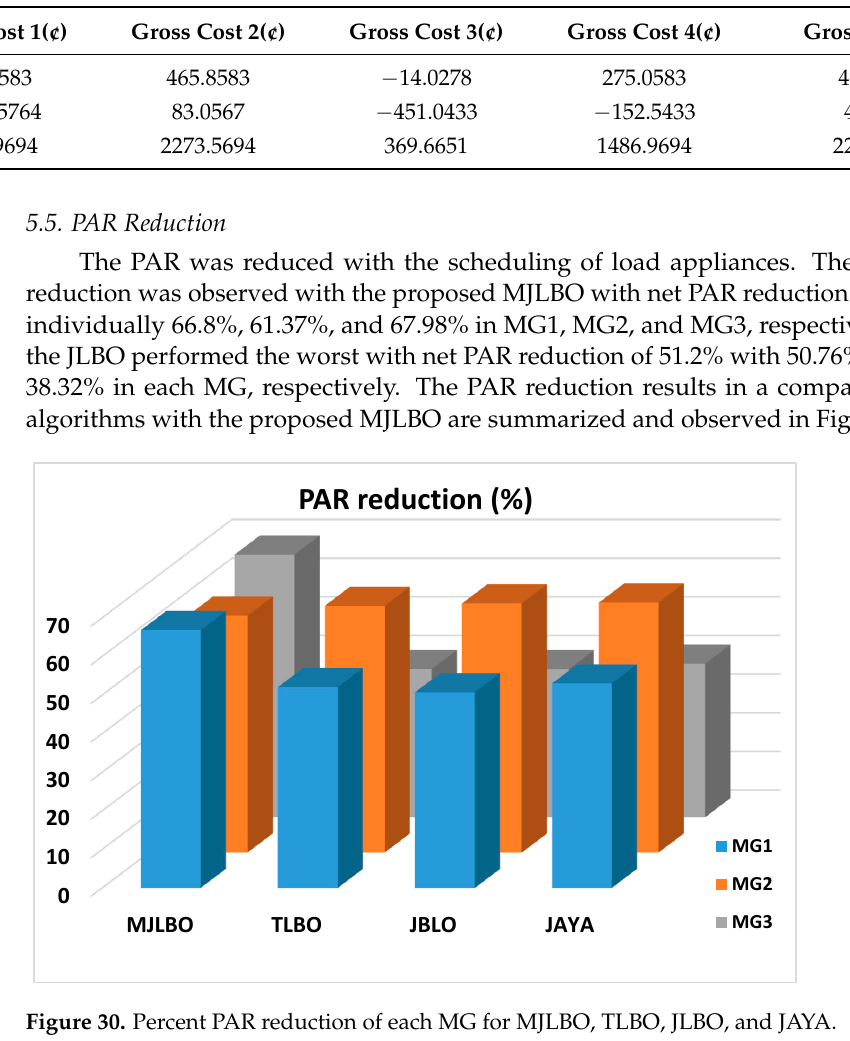
Figure 31. Percent PAR reduction of each MG for each scenario using MJLBO. 5.6. User Disomfort The user discomfort of each scenario is compared and is summarized in Figure 32. The minimum possible user discomfort occurs when all load appliances start operation at their corresponding defined starting time slots. In scenario 1, starting slots are randomly selected from the operation window and have the highest discomfort. Comparatively, in scenario 2, the user discomfort is minimum among all scenarios. The combined system